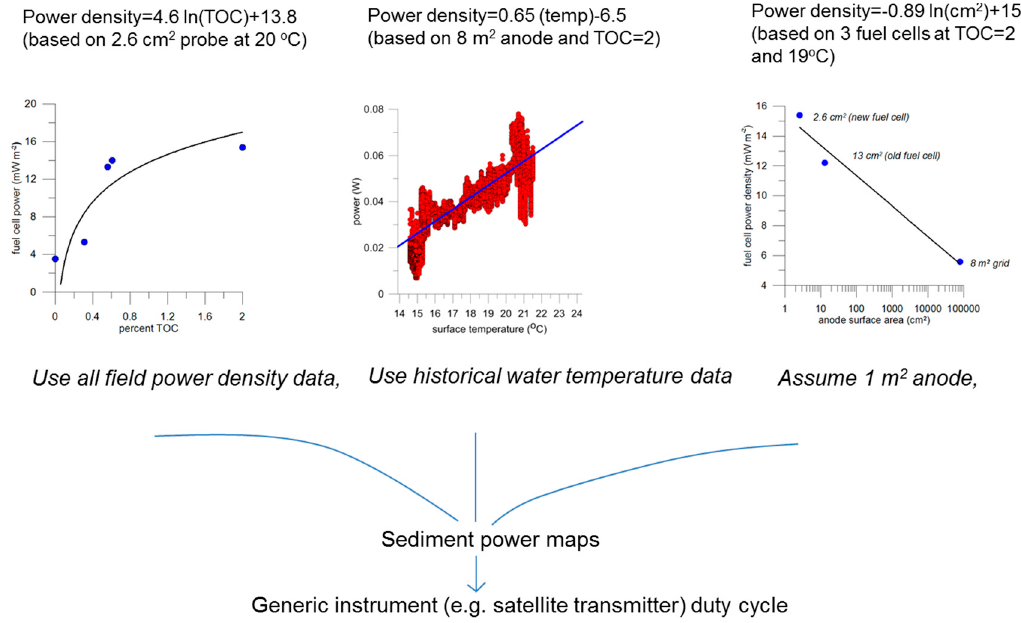
Figure 1. General approach used to predict in situ sediment MFC power potential. Empirical data with varying anode sizes, water temperature, and sediment percent TOC were normalized to consider the performance of a 1 m 2 anode with variable temperature and TOC.